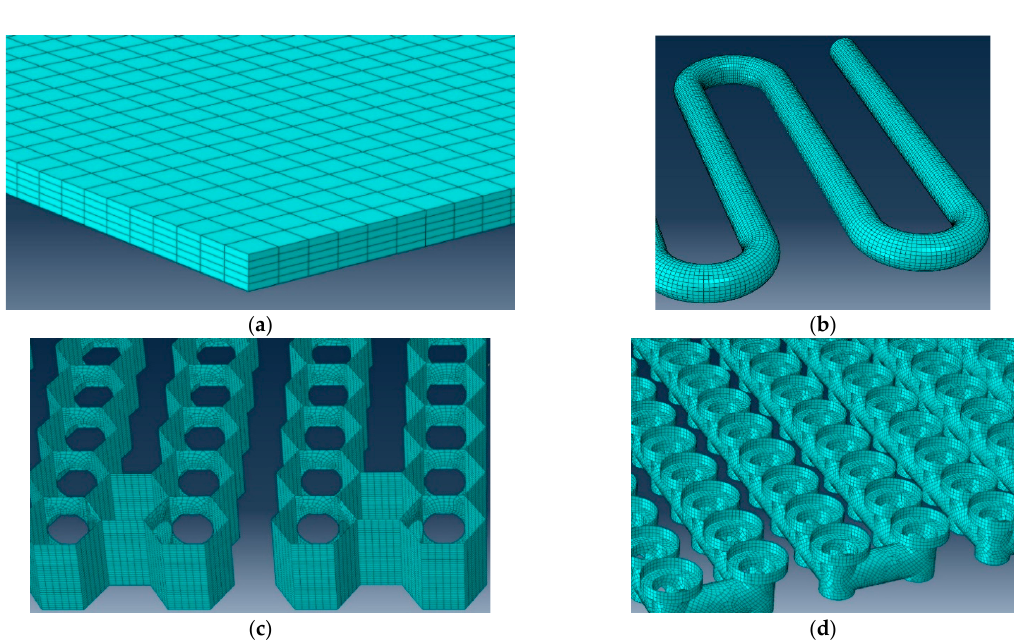
Figure 3. ( a ) Face plate, ( b ) tubular core ( c ) honeycomb core ( d ) mushroom core. Although a fine mesh size was selected, in order to ensure the convergence of the